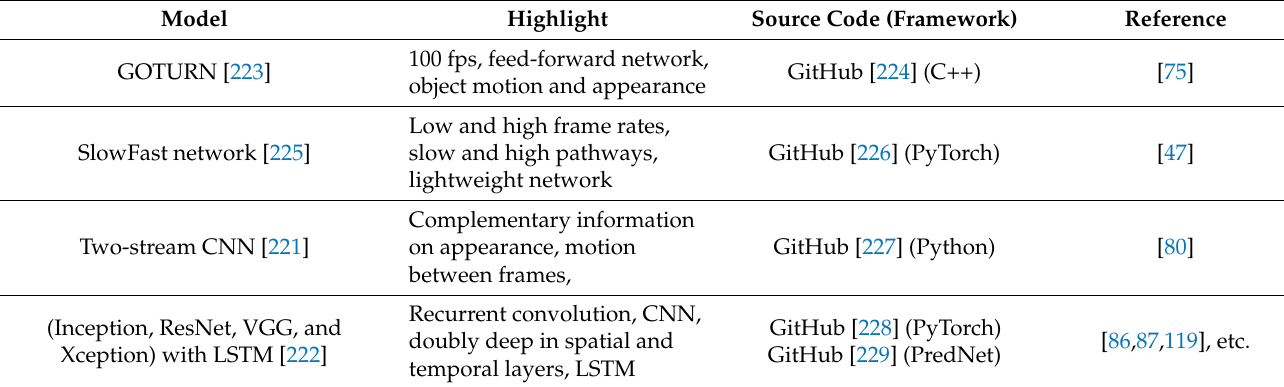
Table 7. Convolutional neural network architectures for